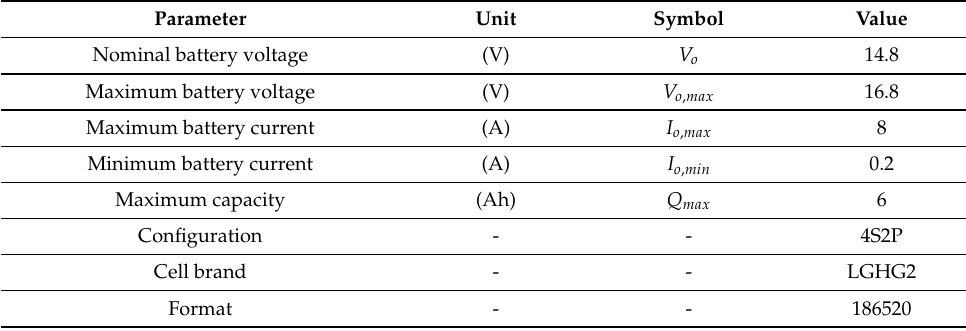
Table 4. Battery